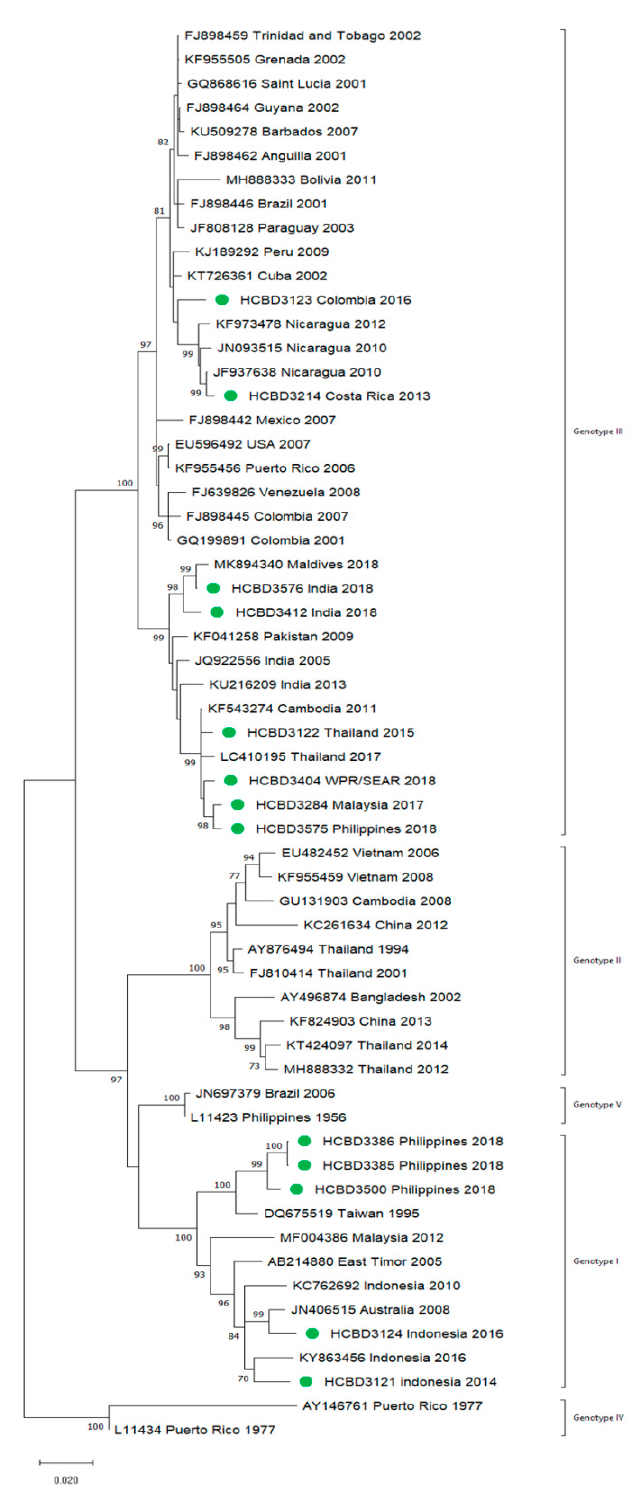
Figure 5. Phylogenetic tree of DENV-3 strains based on the E gene. Strains are denoted by the GenBank accession number, place and year of isolation. The green dots indicate the strains sequenced in this study and the scale bar indicates substitutions per site. The analysis was performed using the maximum likelihood method (TN93 + G + I) with a bootstrap of 1000 replicates.